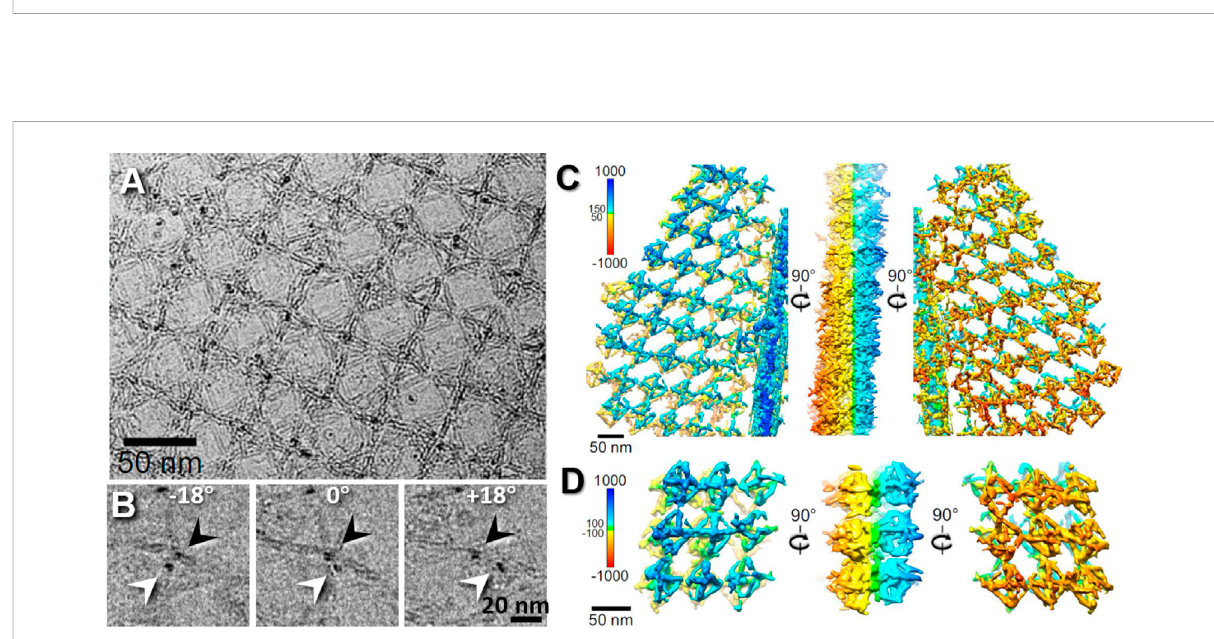
FIGURE 8 Missing-wedge – corrected3DreconstructionofDNAorigamidouble-layered(DL)lattice. (A) Acryo-ETimageofa2DDLlatticeofDNAorigami octahedral cage with ferritin protein imbedded in an extended sheet of vitreous ice. (B) Representative cryo-ET images showing the two ferritins in the top and bottom layers at tilted angles (black and white arrows) in a DL lattice. (C) Selected lattice area of cryo-ET 3D reconstruction (without averaging). (D) Representative 3D density maps after missing-wedge correction by LoTToR. Reproduced with permission (Wang et al.,